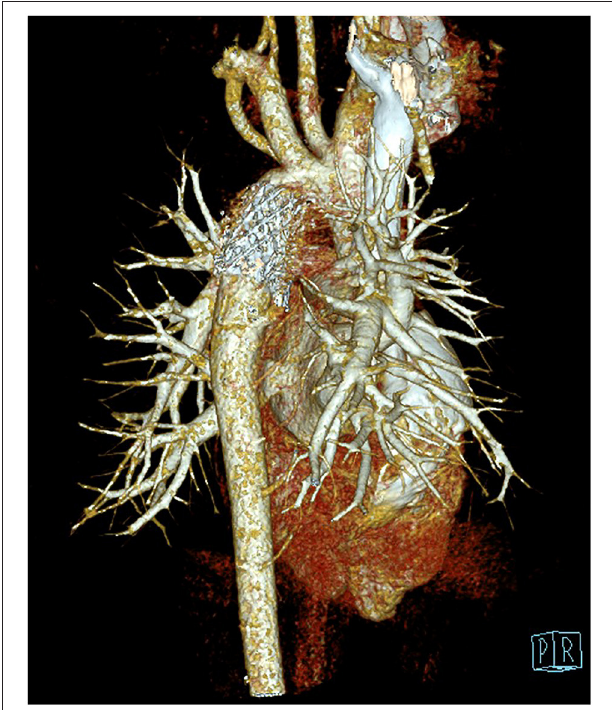
FIGURE 4 | Computed tomography angiography postoperatively showing the coarctated descending aorta after endovascular stent dilatation.